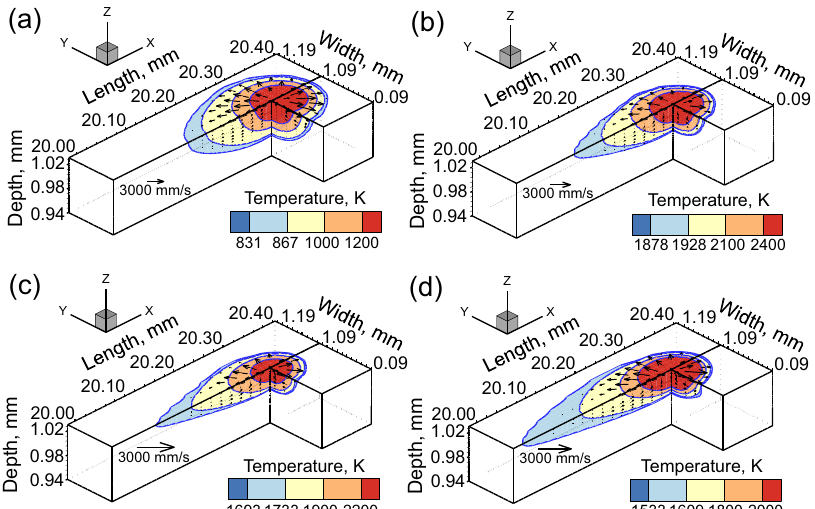
Fig. 3 Temperature and velocity fi elds calculated using the heat transfer and fl uid fl ow model (see Methods section) during PBF-L of different alloys. 3D temperature and velocity fi elds during single track PBF-L of ( a ) AlSi10Mg, ( b ) Ti-6Al-4V, ( c ) SS 316, and ( d ) Inconel 718 using laser power of 60 W, scanning speed 1000 mm/s, hatch spacing of 110 μ m and layer thickness of 30 μ m. The color bands represent the ranges of temperatures corresponding to the fi gure legend. The solidus temperature (831 K for AlSi10Mg, 1878 K for Ti6Al4V, 1693 K for SS 316, and 1533 K for IN 718) isotherm indicates the molten pool boundary. The light blue region with the temperature range between solidus temperature and liquidus temperature represents the two-phase mushy region of the molten pool. The black arrows represent the velocity vectors inside the molten pool. The velocity vectors are radially outwards from the middle where the temperature is high to the rim of the molten pool where the temperature is the solidus temperature. The fl uid fl ow is driven by the Marangoni stress that results from the spatial variation of surface tension due to the local temperature variation. The magnitude of the velocities can be obtained by comparing the length of the velocity vectors with the corresponding reference vectors. The molten pool is elongated in the negative X-axis direction (opposite to the scanning direction) and exhibits a teardrop shape due to the rapid scanning along the positive